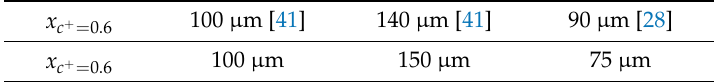
Table 1. Width cation boundary layer defined by c + = 0.6 at the outlet of the domain. 1st row: published values (Nikonenko et al. [28] and Urtenov et al. [41]). 2nd row: this work. x c + = 0.6 100 µ m [41] 140 µ m [41] 90 µ m [28] x c + = 0.6 100 µ m 150 µ m 75 µ m